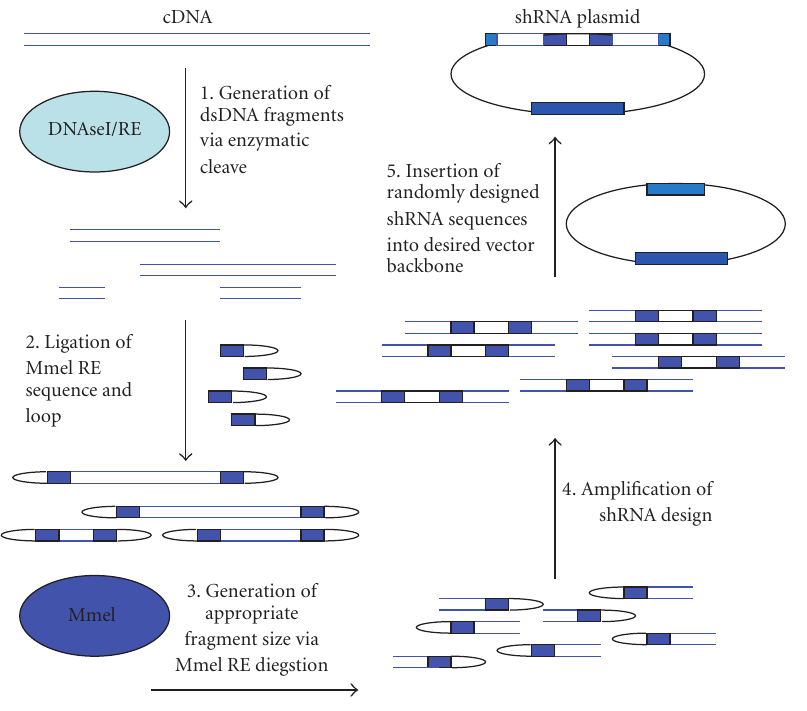
Figure 3: The generation of shRNA libraries from cDNA via enzymatic